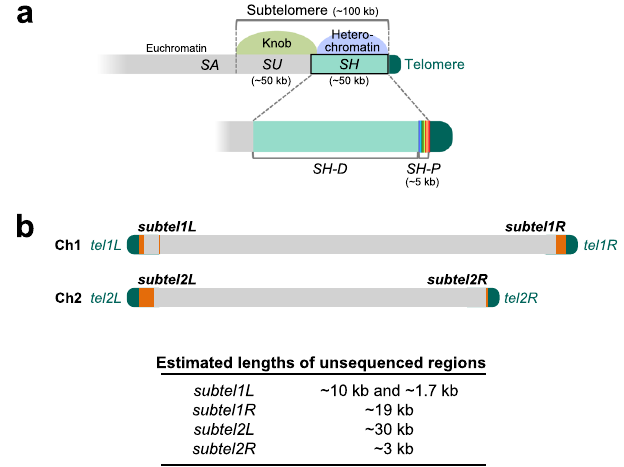
Fig. 1 Structures and previously unsequenced regions of subtelomeres in S. pombe 972 strain. a Schematic illustration of the structures of subtelomeres (~100 kb) of Ch1 and Ch2 in strain 972 . The SH region (~50 kb) shows high sequence identity (>90%) with other subtelomeres. Subtelomeric heterochromatin is formed around the SH region 21 . An SH sequence is composed of two characteristic regions, SH-P (~5 kb) and SH-D . In contrast, the SH -adjacent SU region (~50kb) shows low sequence identities with other subtelomeres, but forms a highly condensed knob structure that is shared among them 24 . SA indicates a subtelomere- adjacent euchromatin region. b Schematic illustration of unsequenced regions of subtelomeres in Ch1 and Ch2 of strain 972 according to PomBase (indicated by orange boxes). Tel1L , tel1R , tel2L , and tel2R indicate telomeres at the left and right arms of Ch1 and those of Ch2, respectively. Subtel1L , subtel1R , subtel2L , and subtel2R indicate subtelomeres at the left and right arms of Ch1 and those of Ch2, respectively. Lengths of unsequenced regions are estimated based on the assumption that these SH sequences show high similarity with that of subtel2R of PomBase. Note that Ch3 is omitted in this panel (see Fig. 2a for the ends of Ch3 in strain 972